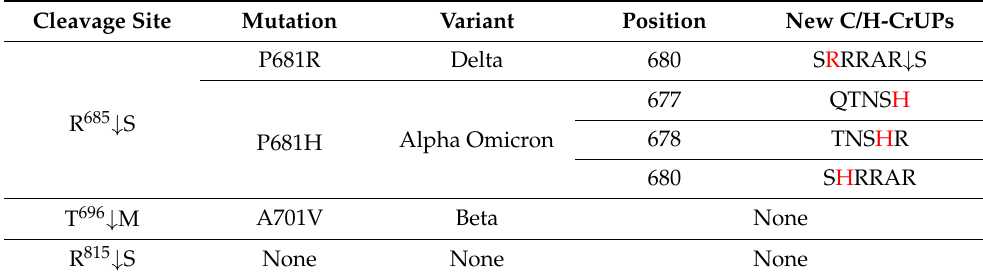
Table 4. C/H-CrUPs arround the Spike protein cleavage sites. Cleavage